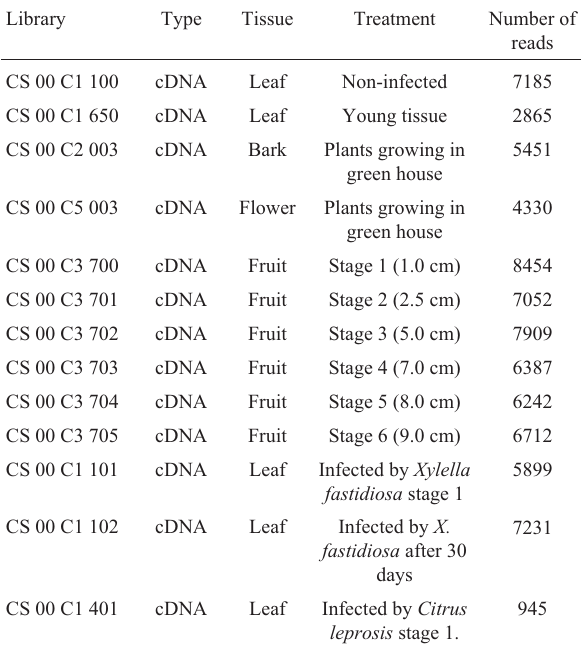
Table 1 - EST libraries in Citrus sinensis variety ‘Pera IAC’ showing specific tissues, several treatments and number of reads. Library Type